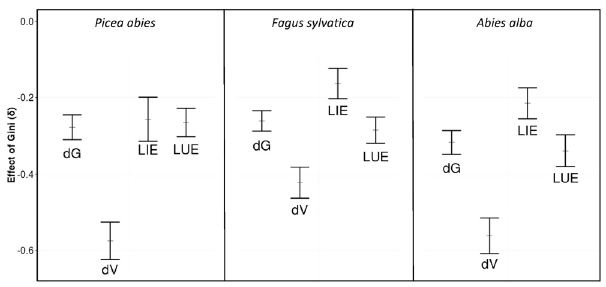
Fig 3. Results from Samsara2 simulations. Production in basal area (dG/dt), production in volume (dV/dt), total light interception (LIE), and light conversion rate (LUE) for Fagus sylvatica , Picea abies and Abies alba . Error bars indicate the confidence interval of δ for each variable